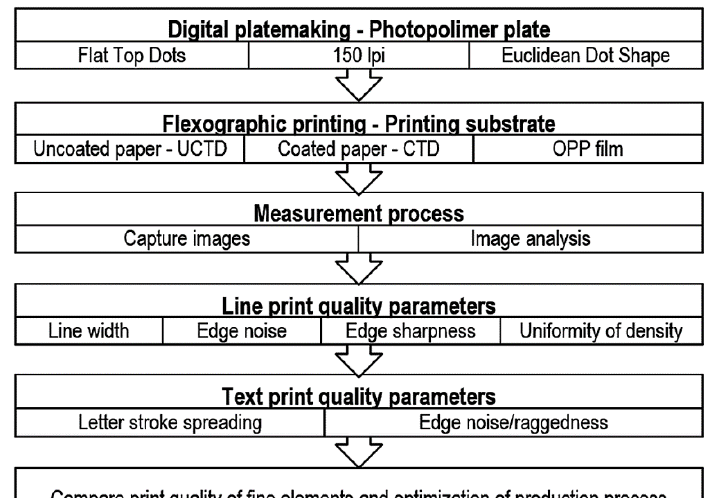
Figure 2. Research framework.